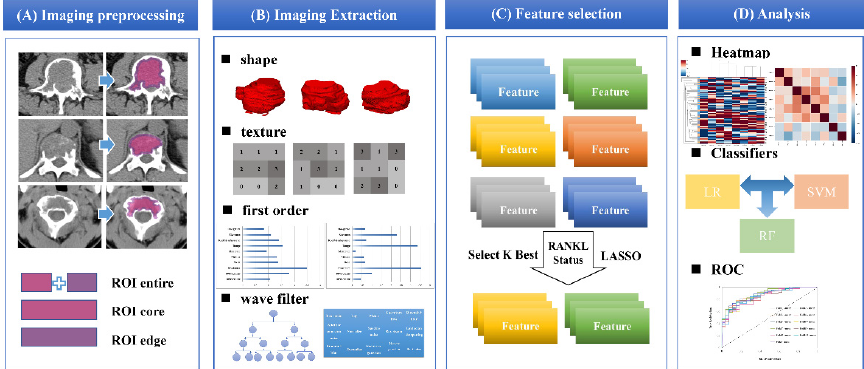
Figure 4. The workflow of necessary steps in this study. ( A ) The VOIs of tumors were manually segmented in axial CT images. Based on the entire tumor VOI, the VOIs of the edge zone and core area were automatically generated. ( B ) The radiomics features were extracted and processed to generate radiomics. ( C ) The sequential feature selection was performed by using Selected K Best and LASSO. ( D ) The RF, LR, and SVM were applied to build the classification models. The performance of the predictive models was evaluated with the area under the ROC curve. VOI, the volume of interest; RF, random forests; LR, logistic regression; SVM, support vector machines; ROC, receiver operating characteristic curve.